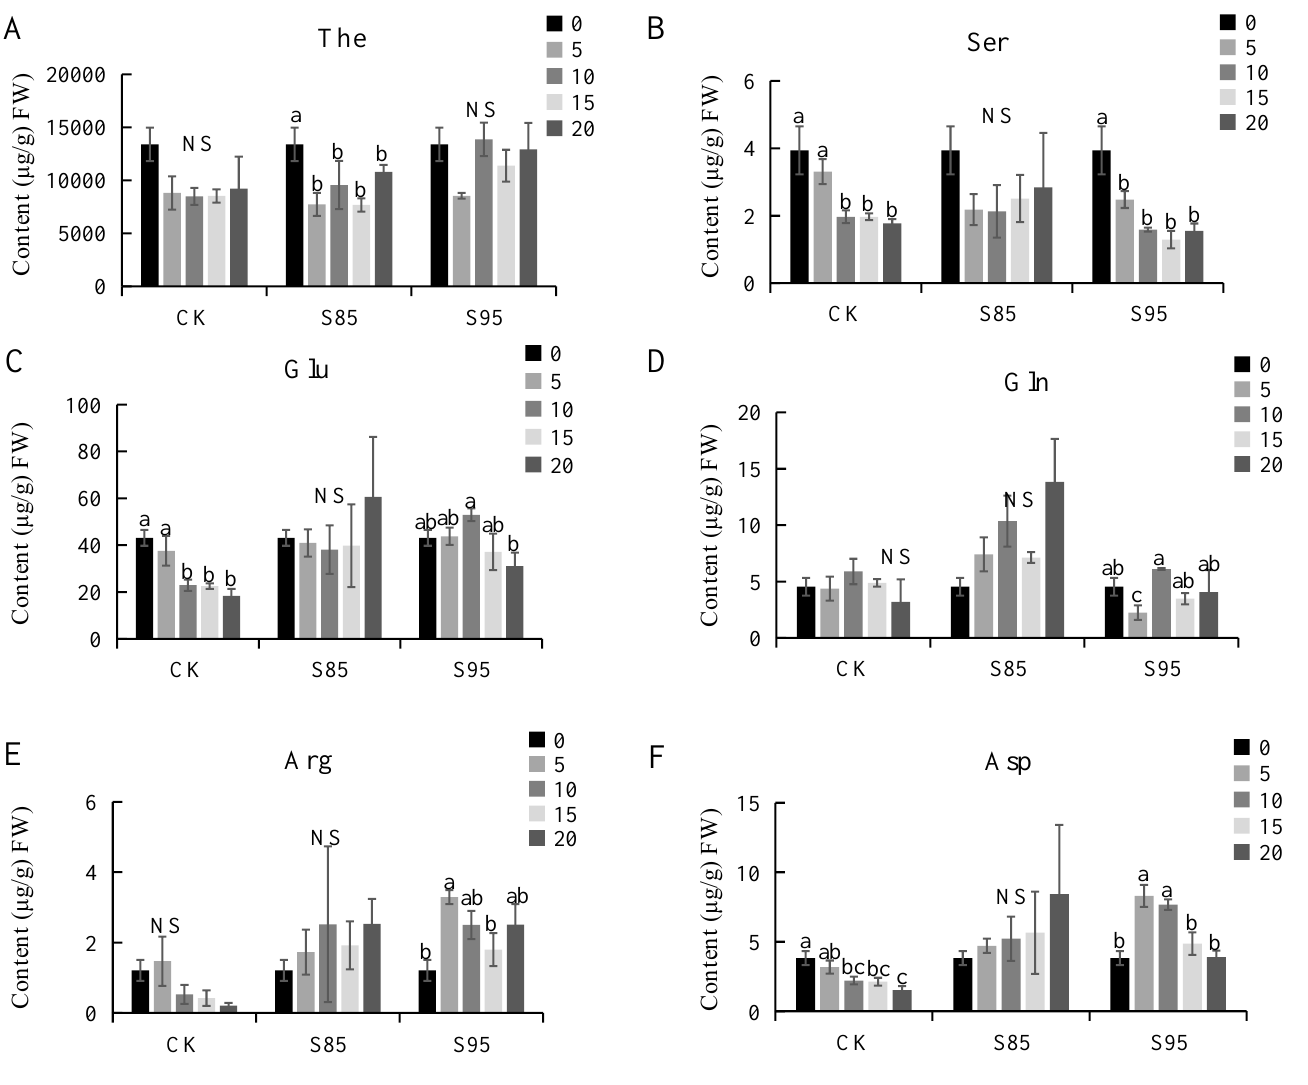
Figure 3. Effect of shading on the amino acid content of tea leaves. ( A ) Theanine content; ( B ) Serine content; ( C ) Glutamate content; ( D ) Glutamine content; ( E ) Arginine content; ( F ) Aspartic acid content. CK is the control. ‘NS’ and different letters above the bar indicate significant ( p < 0.01; n = 3 biological replicates) differences between the control and shaded plants.